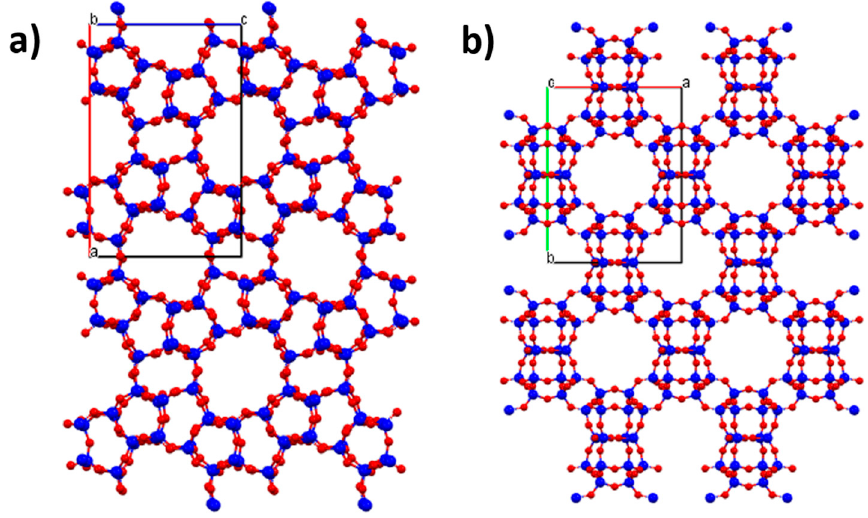
Figure 6. ( a ) MFI and ( b ) STF topologies represented with the program Mercury obtained from the CIF and provided by the International Zeolite Association (IZA) [8,58]. The oxygen atoms are in red, and the silicon/aluminum atoms are in blue.